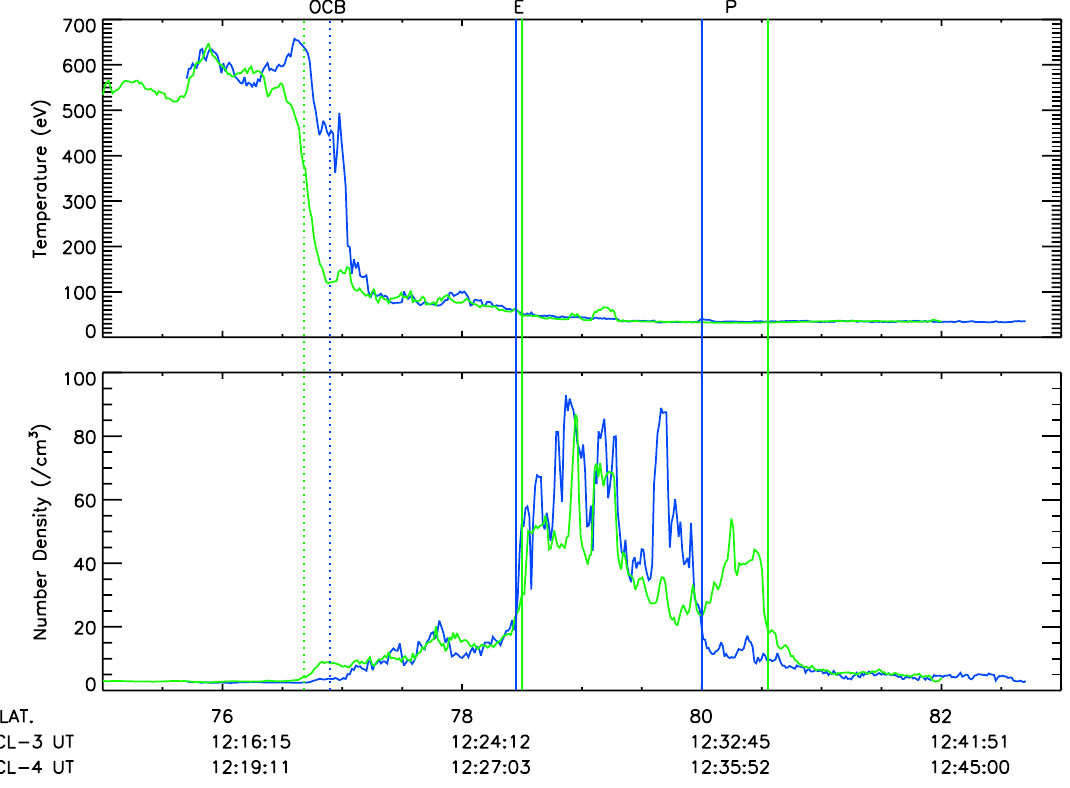
Fig. 3. The upper panel shows the scalar temperature and the lower panel shows the number density moments constructed from HEEA sensor. Blue line refers to Cluster 3 and the green line refers to Cluster 4. The OCB and the equatorward and poleward edges of the cusp are